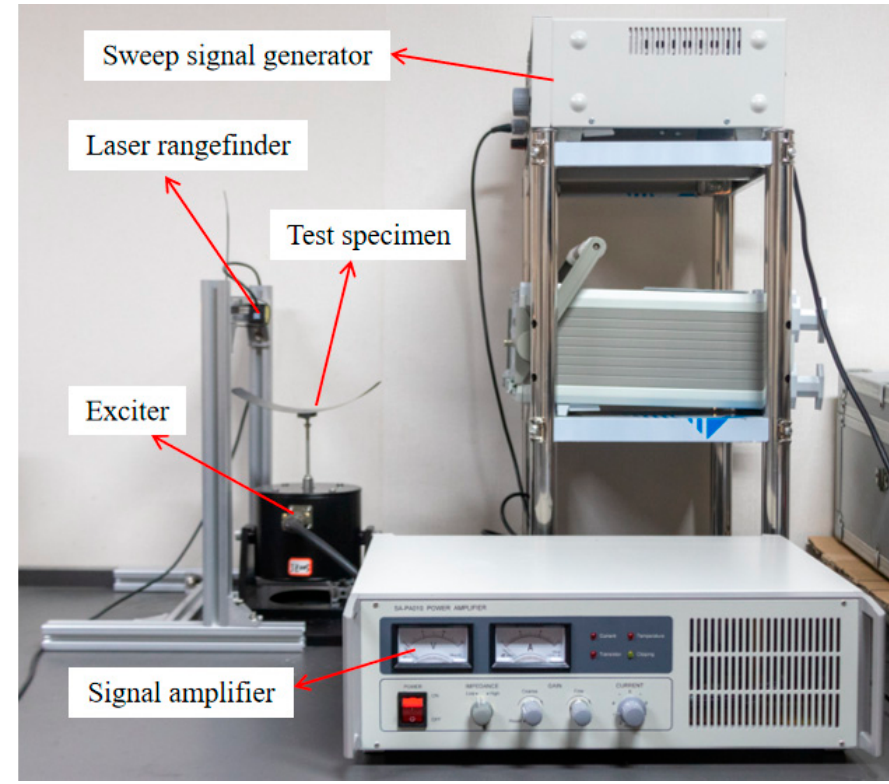
Figure 9. Diagram of the experimental apparatus for frequency-sweep experiment. For the stable state A, the boundary conditions of the bistable laminate were a fixed center and four free edges, which were adapted to conduct the forward and reverse frequency-sweep experiment. The displacement curve of a certain point on the plate was recorded to obtain the frequency response curve of this point on the laminate. Under low-level amplitude excitation, the snap-through of the structure did not occur during the frequency sweep. In Figure 10, the solid black line denotes the result of the forward frequency-sweep experiment, while the dotted red line represents the result of reverse frequency-sweep experiment. The amplitude of the structure reached its maximum value near 15.6 Hz, which is the resonant frequency of the structure obtained in Section 3.1. Before the external excitation frequency reached 15.6 Hz, the response amplitude of the laminates increased. When the external excitation frequency reaches 15.6 Hz, the response amplitude decreased rapidly and then increased slowly. Because there was no snap- through, the frequency response curves of forward and reverse frequency sweeps show a consistent